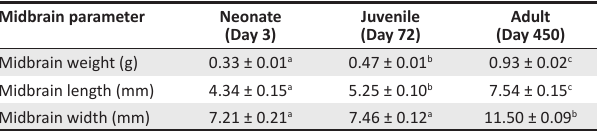
Means on the same row with different alphabet superscripts are significantly different ( p < 0.05). Means on the same row with the same alphabet superscript are not significantly different ( p > 0.05). SEM, standard error of